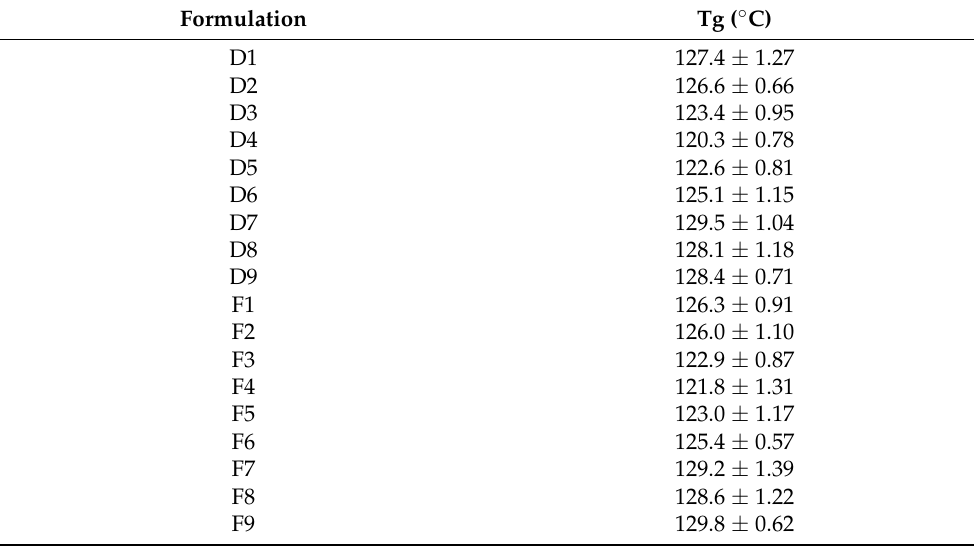
Table 3. The Tg values of the produced polymeric